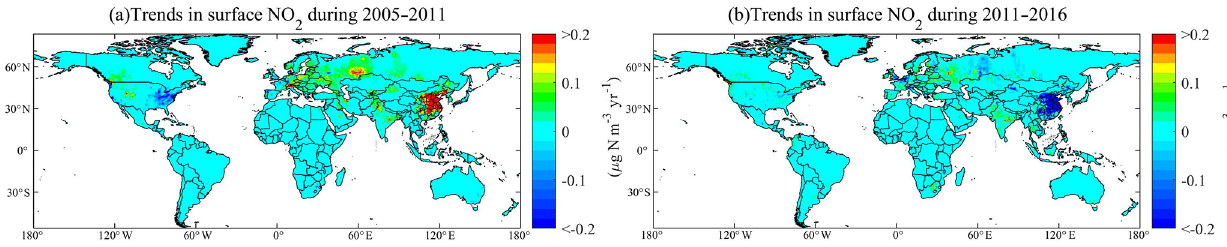
Figure 13. Gridded annual changes in surface NO 2 concentrations gained by OMI retrievals during 2005–2011 (a) and during 2011–2016 (b) in this study. We have released the global surface NO 2 concentrations during 2005–2016 available at the website: https://zenodo.org/